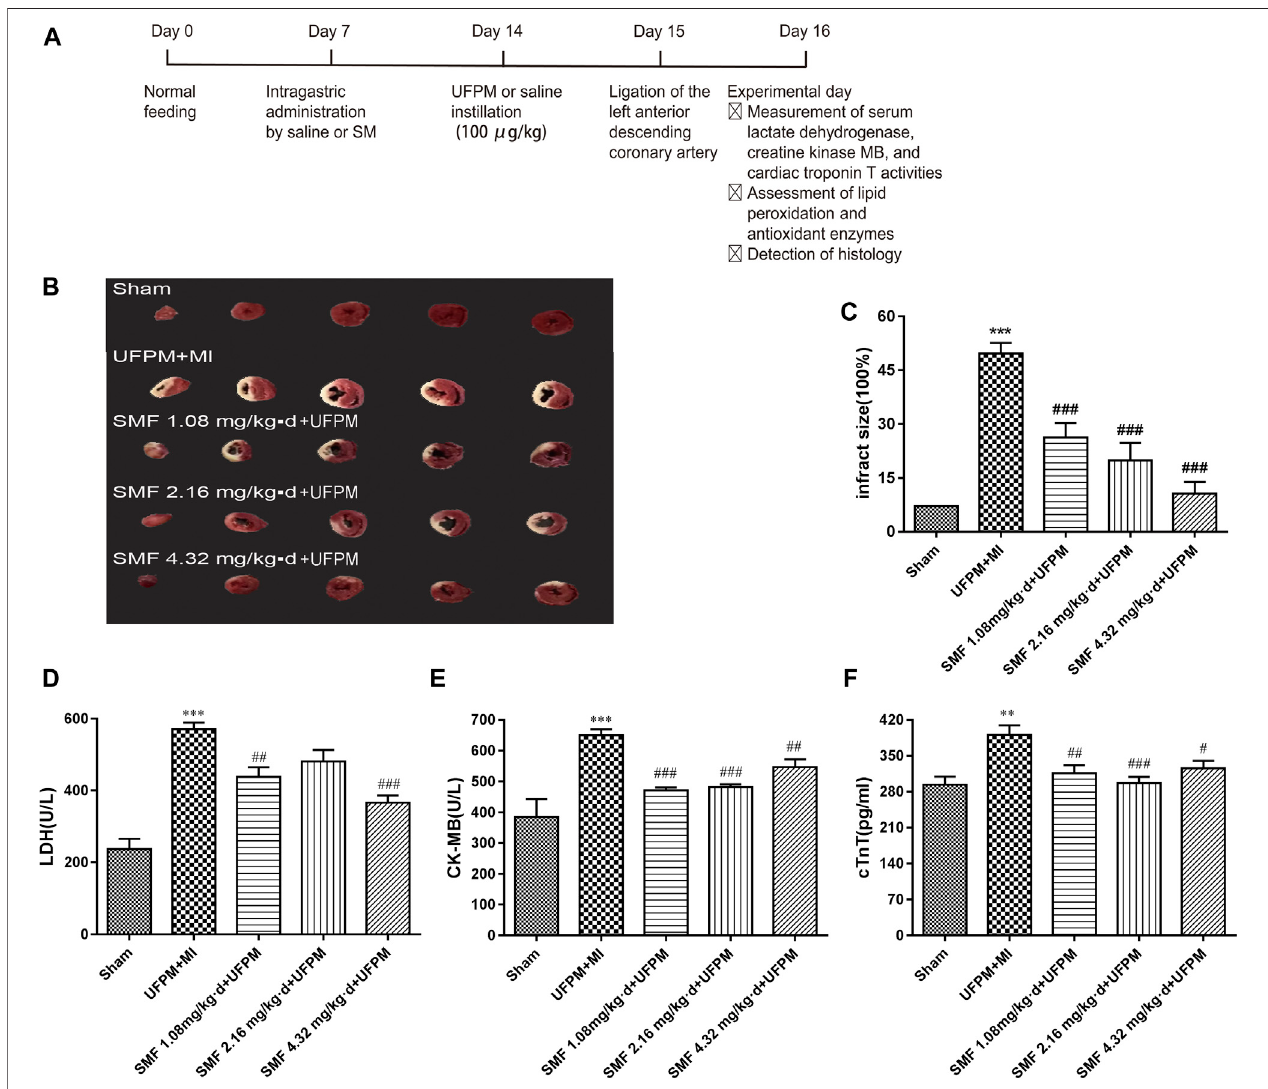
FIGURE 1 | SMF pretreatment protected against MI in UFPM-exposed rats with MI. (A) Treatments and endpoints following intratracheal instillation of saline or ultra fi neparticulatematter(UFPM)withorwithoutrepeatedShengmaiformula(SMF)pretreatment(administeredbyoralgavage)inratswithmyocardialischemia(MI). (B) Isolated rat hearts taken after LAD ligation followed by 24 h ofischemia were sectioned and stained with TTC. (C) Infarctsize quanti fi cation byTTC staining. Infarct sizes werequanti fi edand expressed asapercentage ofthe totalleftventriclearea.Ratios wereobtained insixratsper group(means ± SEM). Levelsof (D) LDH, (E) CK- MB, and (F) cTnT in rat sera. All values are expressed as mean ± SD, n (cid:2) 6 per group. LAD, left anterior descending; TTC, triphenyltetrazolium chloride. * p < 0.05, ** p < 0.01 vs. sham. # p < 0.05, ## p < 0.01 vs. UFPM + MI.